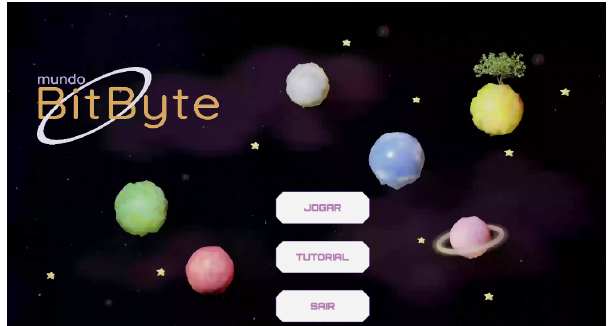
Figure 1. Start screen of the Game Mundo Bit Byte